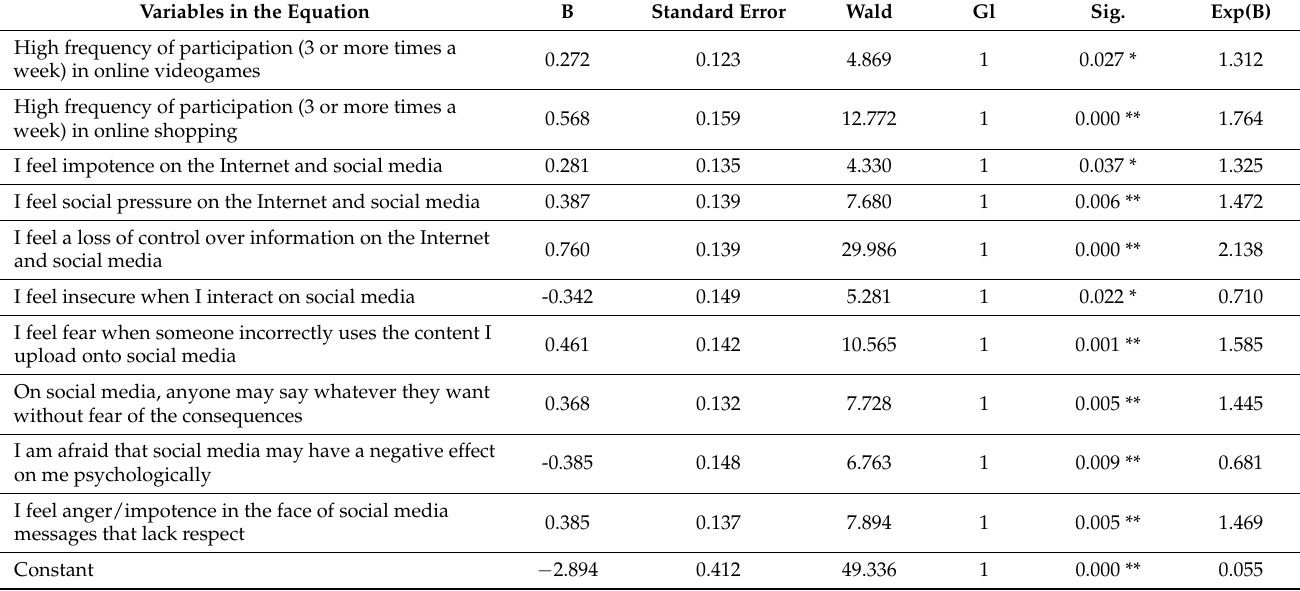
Table 4. Logistic regression model on the probability of perceiving risk or danger in compulsive shopping.